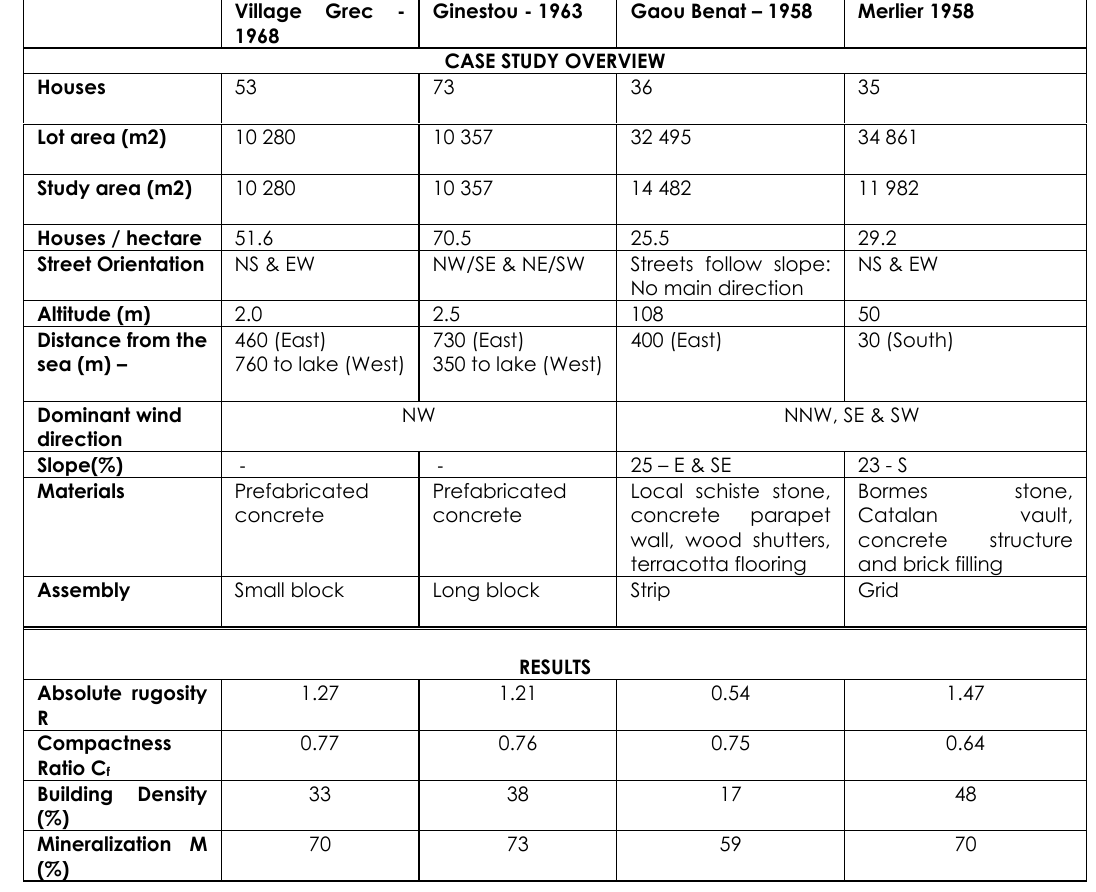
Table 2. Case study overview (top) and results